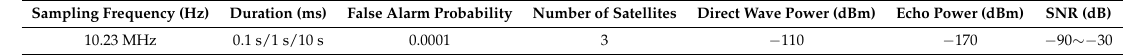
Table 6. Parameter setting of experiment 3.